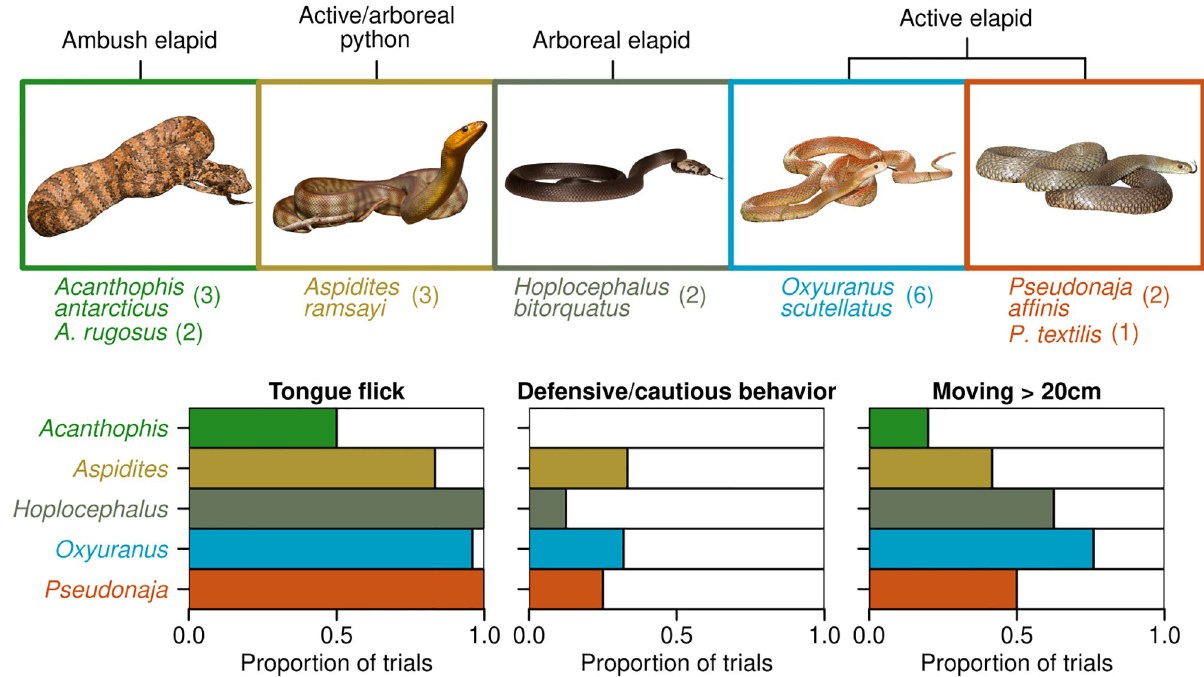
Fig 2. Genus-level behavioral comparisons of snakes in control trials. Genus groupings of snakes, snake count per species (n = 2–6) and presence of three dominant behaviors (tongue flicks, defensive/cautious behaviors and > 20cm movement) (from n = 4 trials per snake) as a proportion of control trials (n = 4 per snake). Defensive/cautious behaviors included cautious exploration, fixation, freezing, hisses, head jerks, jaw drops and periscoping (Table 1). Snake images are not to relative scale. See S1 Table in S1 File for the length of all included snakes. Image credits to CNZ: Acanthophis , Aspidites , Hoplocephalus ; to CJH: Oxyuranus , Pseudonaja .